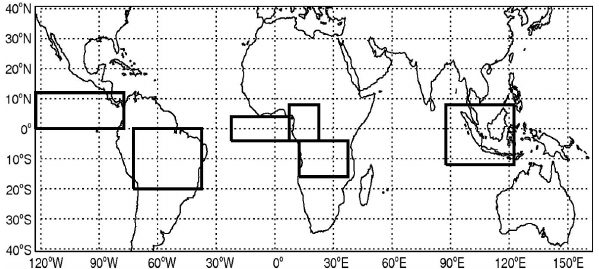
Fig. 7. Location of the regions discussed in this